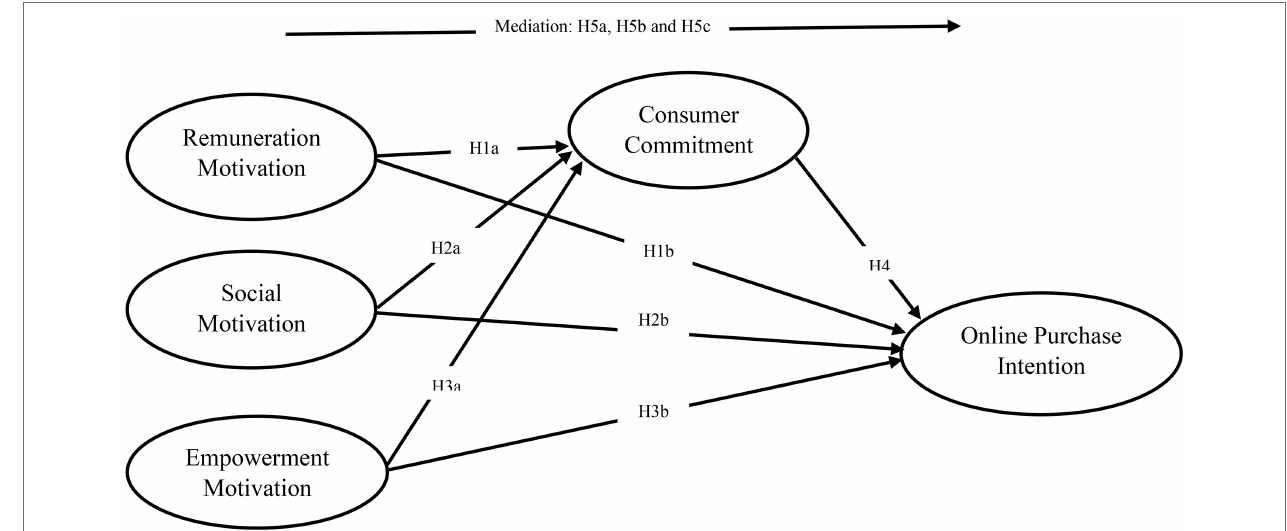
FIGURE 1 | Conceptual